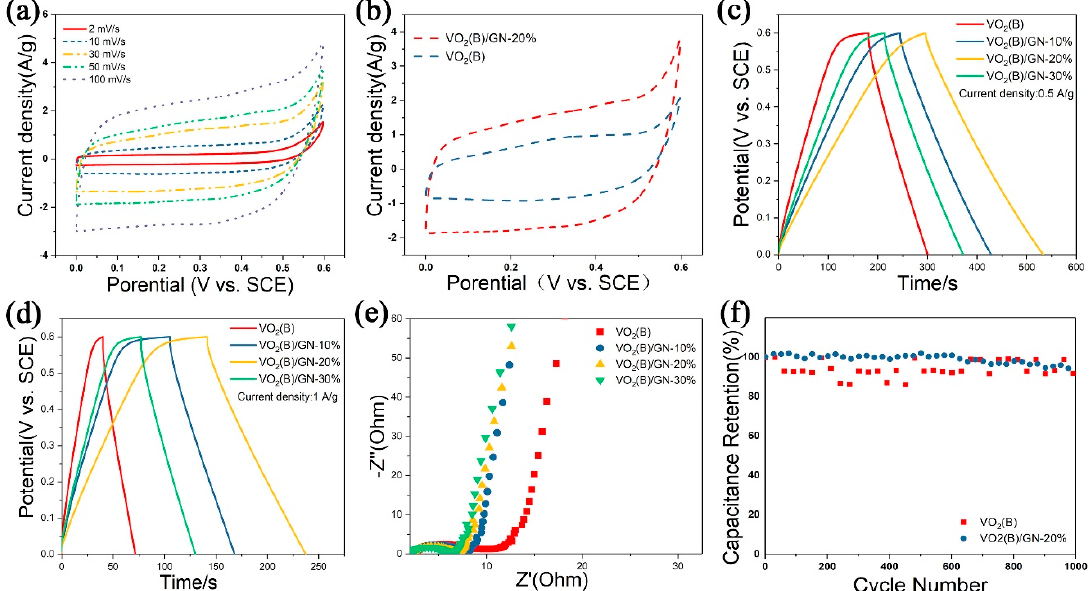
Figure 3. ( a ) The CV curves of pure VO 2 (B)/GN (20%) composite electrodes at different scan rate, ( b ) the CV curves of pure VO 2 (B) and VO 2 (B)/GN (20%) composite electrodes at 50 mV s − 1 , ( c ) the GCD curves of pure VO 2 (B) and VO 2 (B)/GN (20%) composite electrodes at 0.5 A g − 1 , ( d ) the GCD curves of pure VO 2 (B) and VO 2 (B)/GN (20%) composite electrodes at 1 A g − 1 , ( e ) the Nyquist impedance plots of pure VO 2 (B) and VO 2 (B)/GN composites electrodes, and ( f ) the cycling stability of pure VO 2 (B) and VO 2 (B)/GN (20%) composite electrodes at 15 A g − 1 .